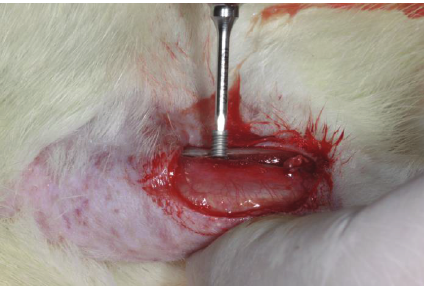
Figure 1: Implant installation.